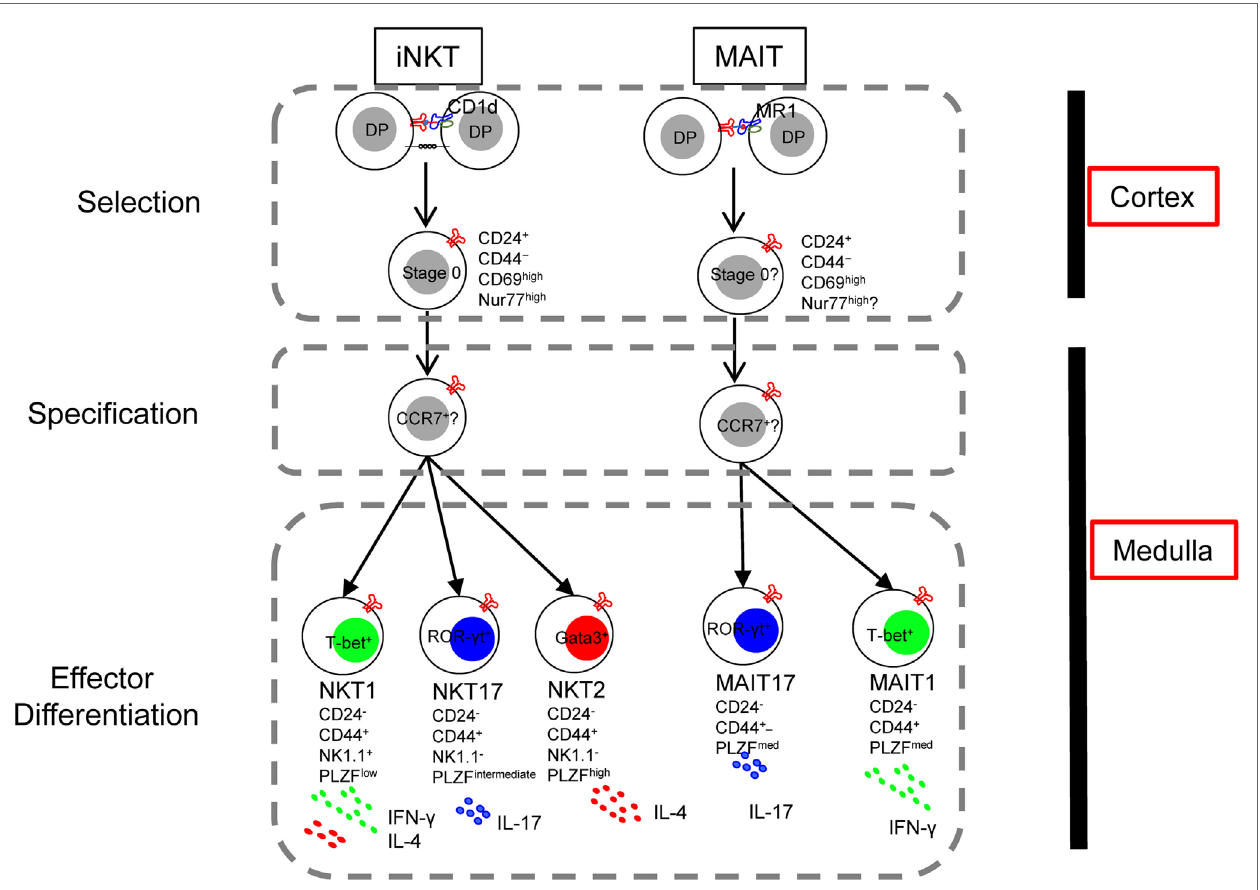
FigURe 3 | The lineage-diversification model of invariant natural killer T (iNKT) cell development parallels that of mucosal-associated invariant T (MAIT) cells. Interactions between double-positive (DP) thymocytes expressing the appropriate T cell receptor and CD1d or MR1 on neighboring thymocytes generates CD24 + CD44 − lineage committed stage 0 cells (Selection). With downregulation of CD24 and upregulation of the signature transcription factor PLZF, PLZF high progenitor cells migrate from cortex to medulla, likely mediated by the chemokine receptor CCR7 (Specification). In the medulla, responding to various cues, the PLZF high CCR7 + progenitor further differentiates into distinct effector subsets (Effector differentiation). Thus, the thymic development of iNKT cells and MAIT cells are parallel in many aspects except that an IL-4/13-producing MAIT cell has not been